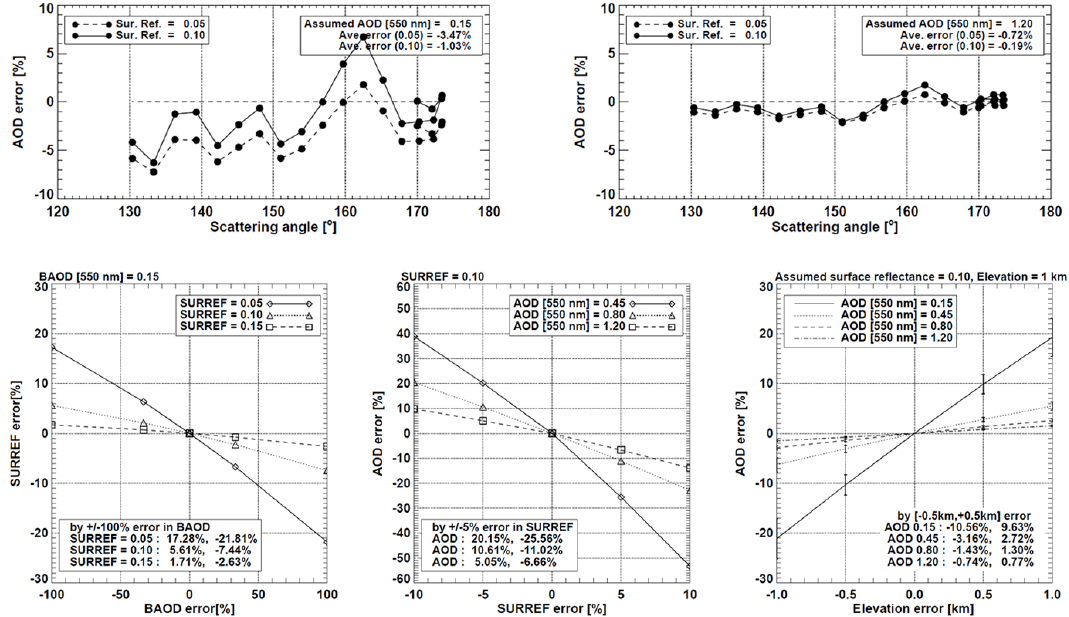
Figure 7. Uncertainties in retrieval of AOD and surface reflectance; (a, b) AOD error depending on scattering angle for two cases of AOD (0.15, 1.20) and two cases of surface reflectance (0.05, 0.10); (c) error in surface reflectance according to BAOD assumption error for three conditions of BAOD (0.05, 0.10, and 0.15); and (d) sensitivity of AOD error to error in surface reflectance and elevation for each assumed condition of